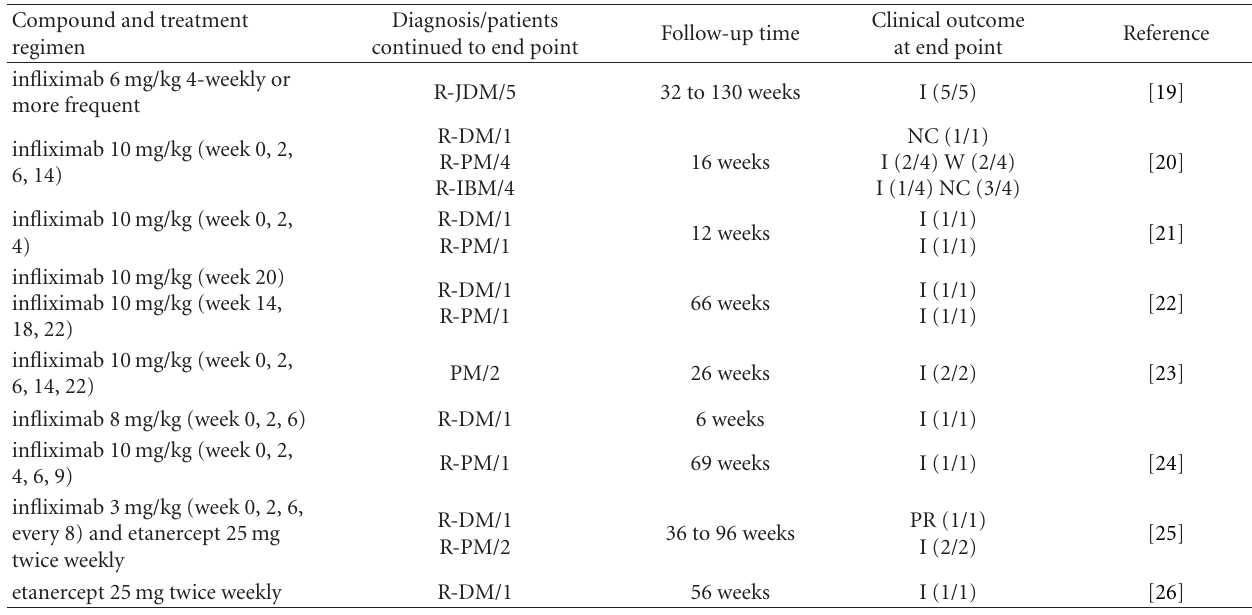
Table 1: Tumor necrosis factor inhibitors for treating inflammatory myopathies: published trial results for infliximab and etanercept. Compound and